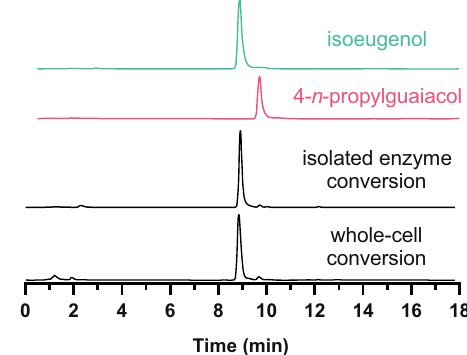
Fig. 8 | HPLC analysis of the conversion of 4- n -propylguaiacol by PROGO. The fi rsttwochromatogramsshowtheelutionofthereferencecompounds,isoeugenol (green) and 4- n -propylguaiacol (red). The chromatograms of the conversions (black) show depletion of 4- n -propylguaiacol (R t =9.7min) to form isoeugenol (R t =8.9min). The conversions were performed in 48h at 25°C using 10% (v/v) DMSO, 50mM KPi (pH 7.5) as buffer. For the conversion by isolated enzyme, 0.5 gram (3.0mmol) 4- n -propylguaiacol and 18.5mg (0.30 µ mol) puri fi ed PROGO was used in a 60mL reaction volume. For the conversion by wholecells, 1.27gram 4- n - propylguaiacol (7.6mmol)and E. coli cells from a 150mL culture ( fi nalOD 600 =29) was used in a 125mL volume.